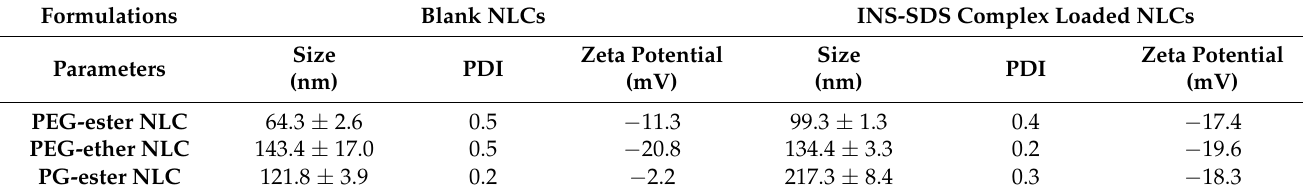
Table 3. Characterization of different NLC formulations regarding size, polydispersity index (PDI), and zeta potential. Data indicated as means ± SD ( n =